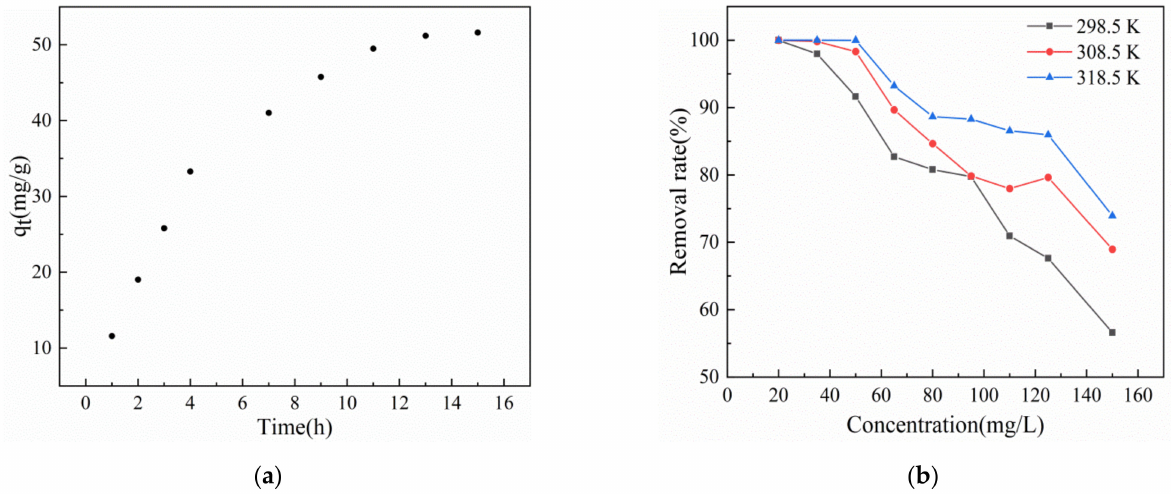
Figure 5. ( a ) The effect of time on the removal of Cr(VI) by adsorbent, ( b ) the effect of different temperature and concentration on the removal of Cr(VI) by